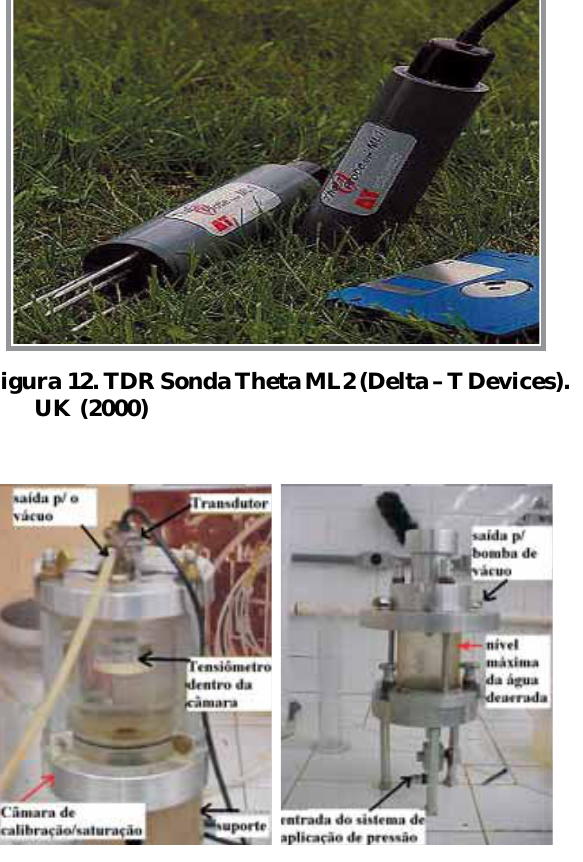
Figura 13. Câmara de calibração e câmara de saturação da pedra porosa. Diene